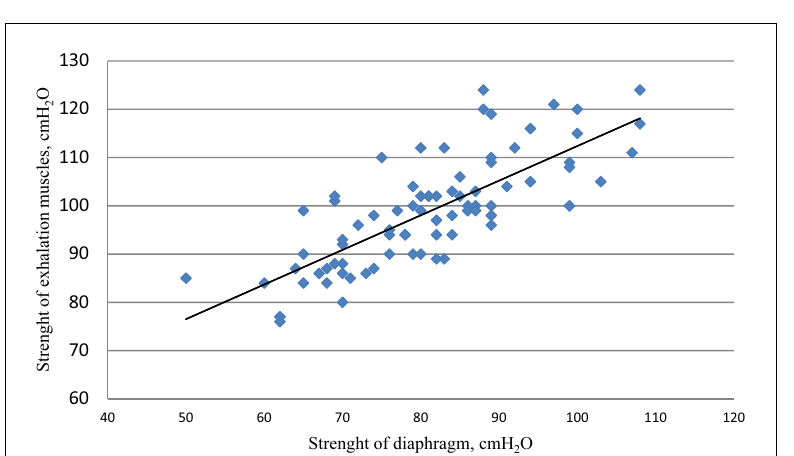
Figure 2. Correlations between the strength of diaphragm and of exhalation muscles for the study subjects